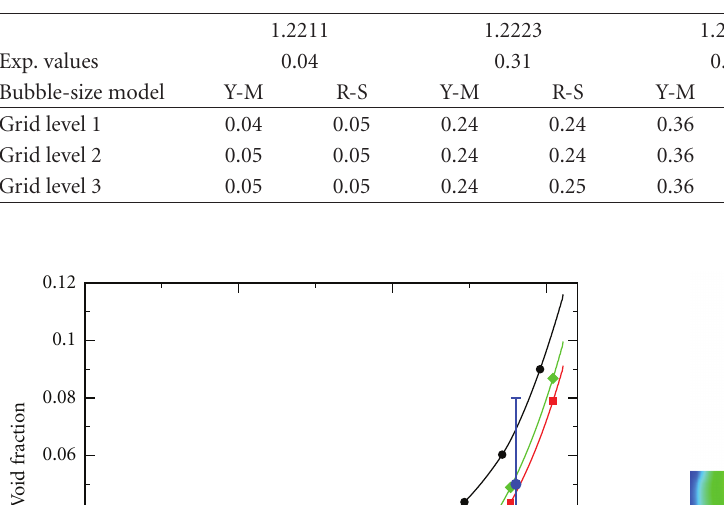
Table 7: Cross-section averaged void fraction obtained on the three grid levels for the two interfacial-area models used. Y-M stands for the Yao-Morel model; R-S stands for the Ruyer Seiler model.